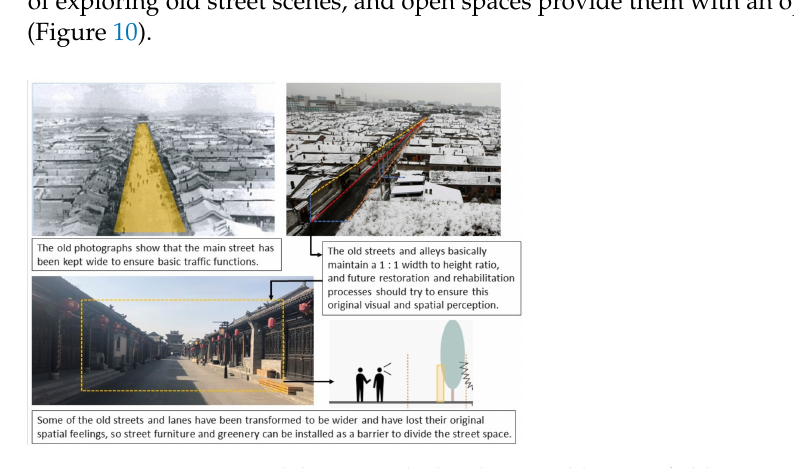
Figure 10. Preserving and designing the height-to-width ratio of old streets are necessary to recon- struct the old urban scenes and street vistas. Source: